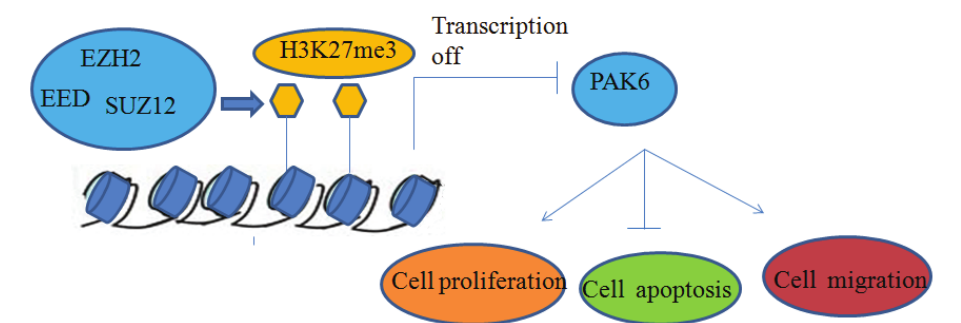
FIGURE 1 - The epigenetic regulation of PAK6 in